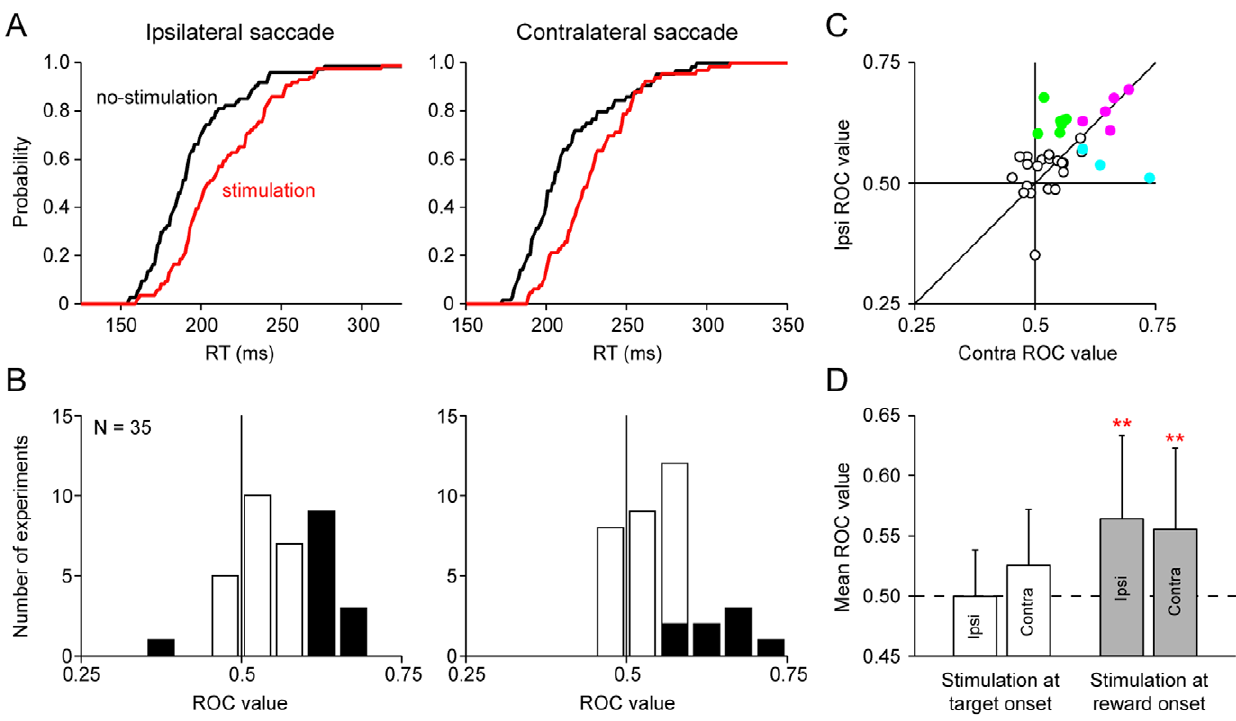
Figure 2. Effect of LHb stimulation on saccade latency. ( A ) Cumulative distribution of saccade latencies for ipsilateral saccades (left) and contralateral saccades (right). Red line indicates the cumulative distribution when saccades were followed by LHb stimulation (that is, stimulation condition). Black line indicates the cumulative distribution when saccades were not followed by LHb stimulation (that is, no-stimulation condition). ( B ) Distribution of ROC values comparing saccade latency between the stimulation and no-stimulation conditions for ipsilateral saccades (left) and contralateral saccades (right) (N=35). ROC values more than 0.5 indicate longer latencies in the stimulation condition. Black bars indicate experiments with a significant difference in saccade latency between the stimulation and no-stimulation conditions (P , 0.05, Wilcoxon rank-sum test). ( C ) Comparison of the ROC values between ipsilateral saccades (ordinate) and contralateral saccades (abscissa) (N=35). Green, cyan and red dots indicate experiments with a significantly longer latency in the stimulation condition for ipsilateral saccades, contralateral saccades and both of them, respectively (P , 0.05, Wilcoxon rank-sum test). White dots, no significance. ( D ) Mean ROC values in the original procedure (LHb stimulation at reward onset, gray bars, N=35) and in the control procedure (LHb stimulation at target onset, white bars, N=9). Double asterisks indicate significant deviation from 0.5 (P , 0.01, Wilcoxon signed-rank test). Error bars indicate s.d.